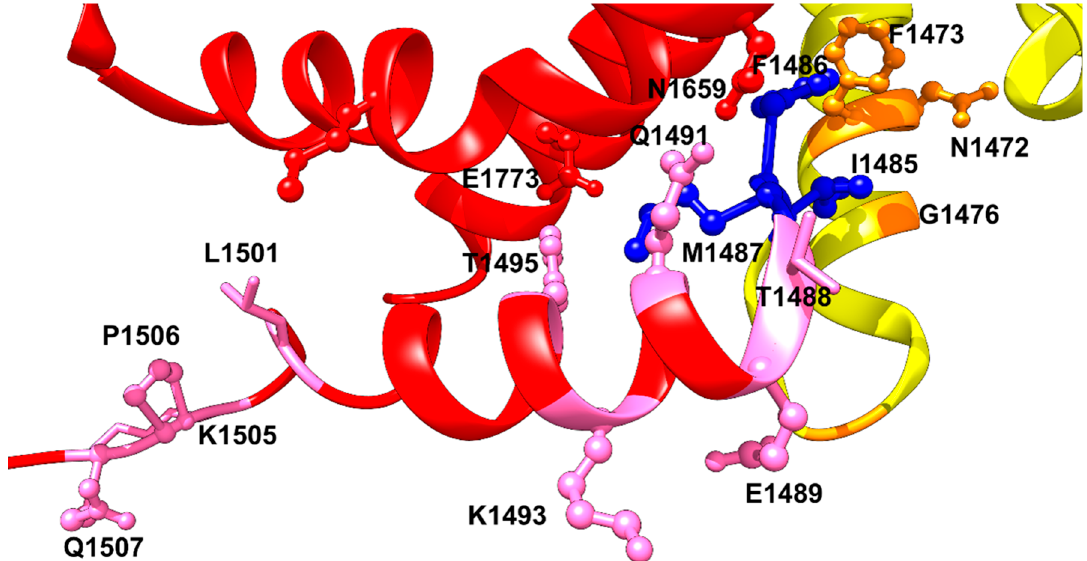
Figure 2. The IFM motif, shown in dark blue ball and sticks interacting with its binding pocket formed by S4–S5 linker, S5 and S6 of DIV, and the S6 of DIII. DIII is shown in yellow, and DIV in red. Upstream (USM) and downstream (DSM) mutations are shown as orange and pink ball and sticks, respectively.